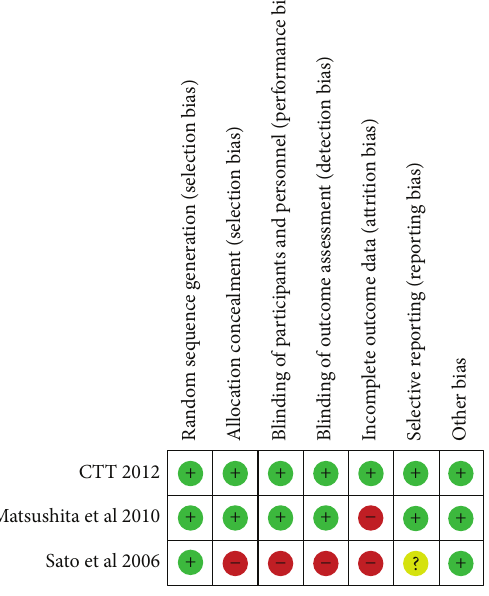
Figure 2: Quality of the RCT articles.